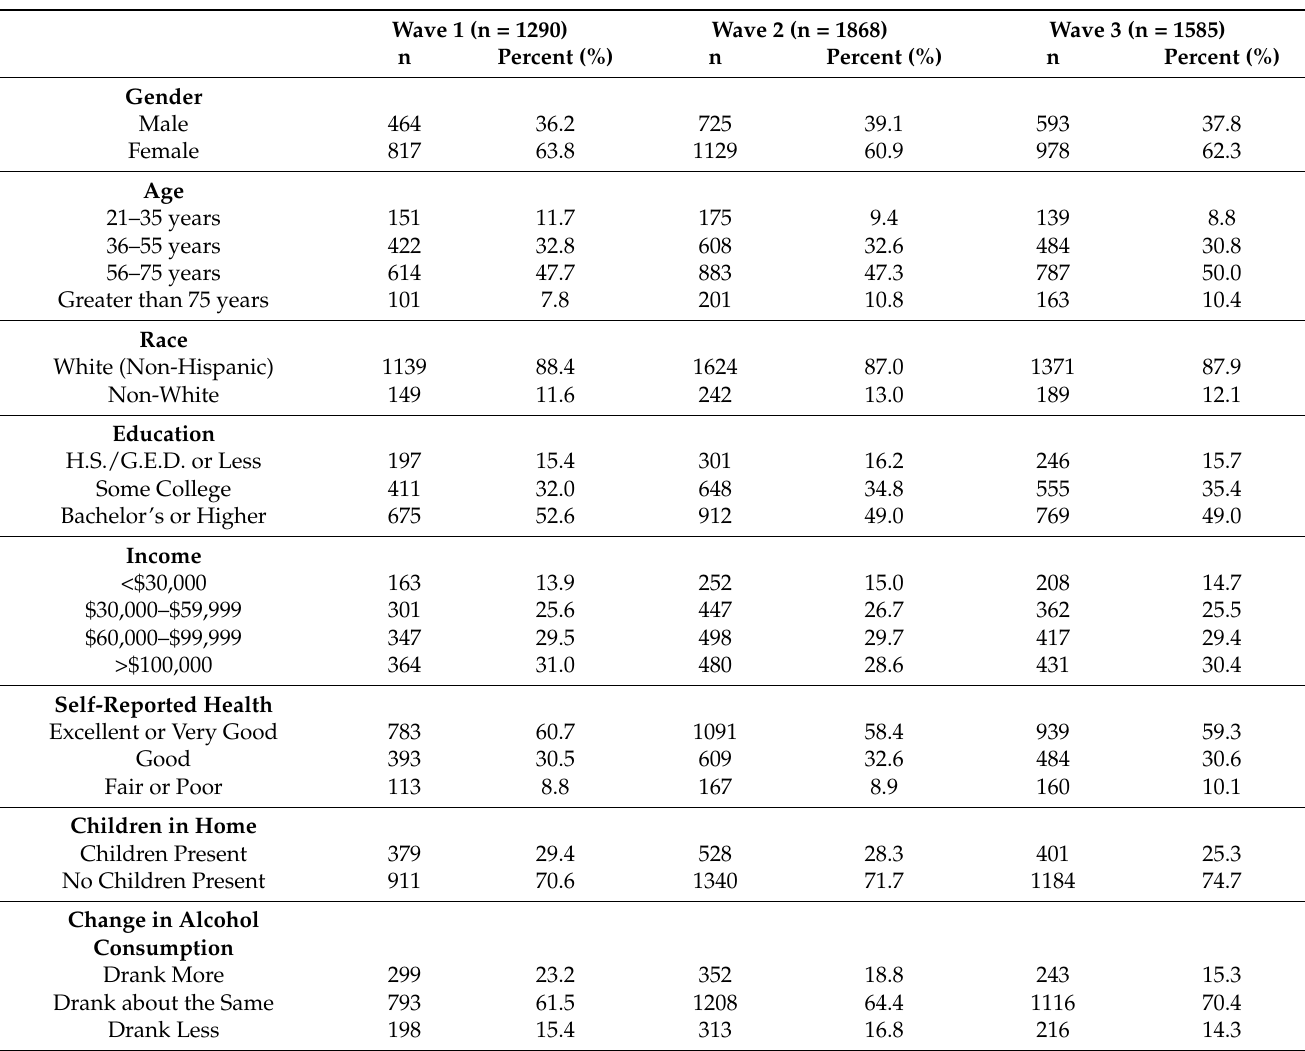
Table 1. Selected Demographics and Characteristics of Each